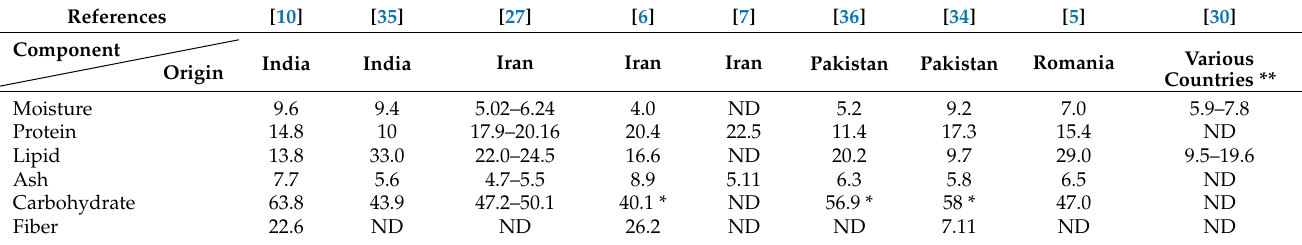
Table 2. The nutritional composition of basil seeds (g/100 g dry weight basis).